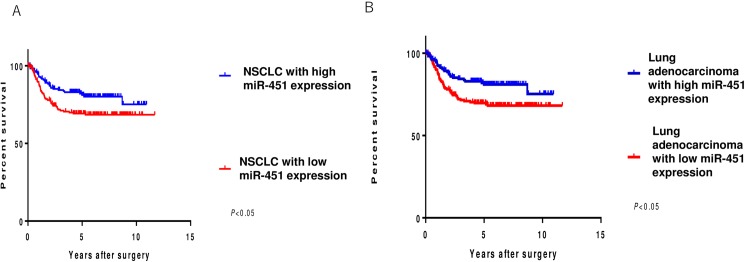
miR-451 and the disease-free survival (DFS) in non-small cell lung cancer (NSCLC) and lung adenocarcinoma cases.(A) NSCLC cases with a low miR-451 expression showed a significantly worse prognosis than cases with a high miR-451 expression. (B) Lung adenocarcinoma cases with a low miR-451 expression showed a significantly worse prognosis than cases with a high miR-451 expression. Tick: censored cases.